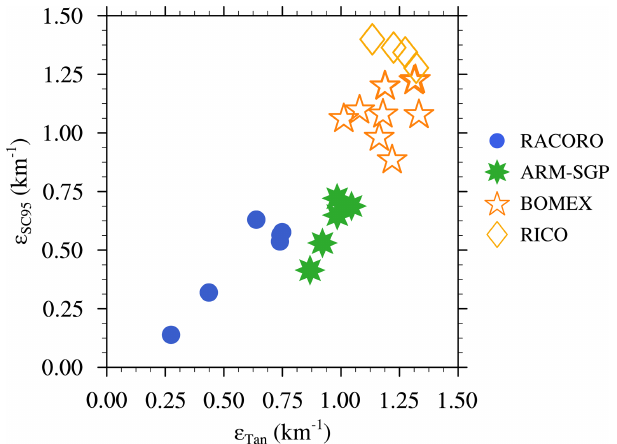
Figure 17. Relationship between dilution rate calculated using Eq. (1) ( ε SC95 ) and dilution rates approximated using Eq. (26) in Tan et al. (2018) for all 25 experiments. The non-dimensional coef- ficients c ε has been set to